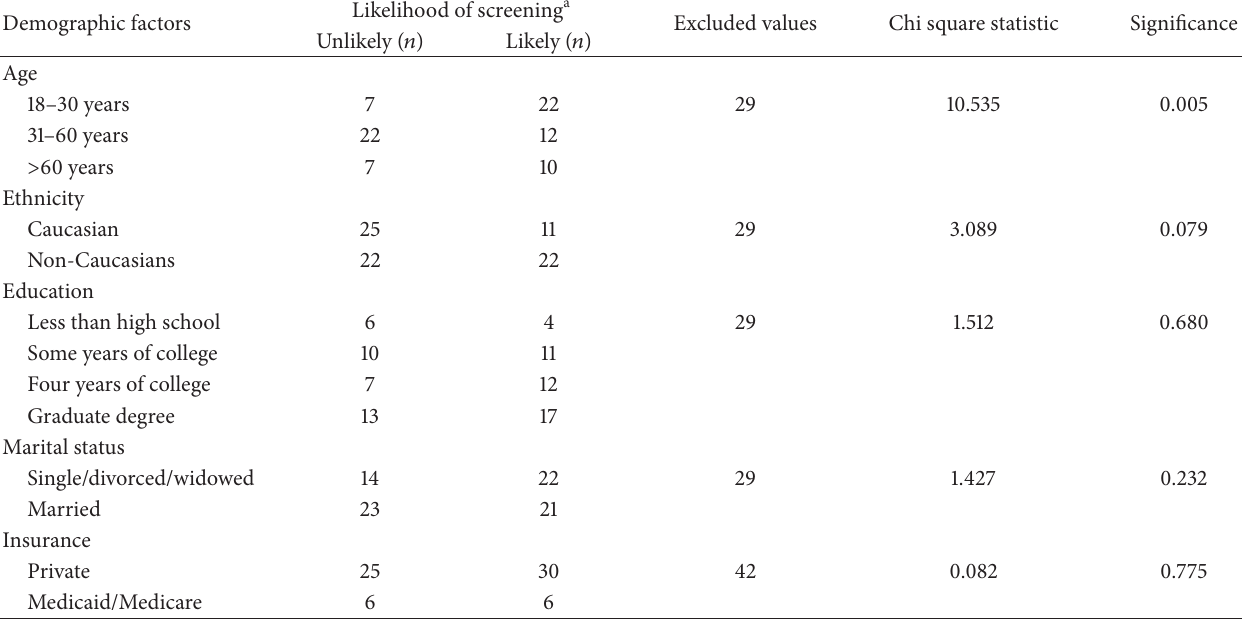
Table 4: Chi square analyses to test associations between respondents’ sociodemographics and intention to screen.